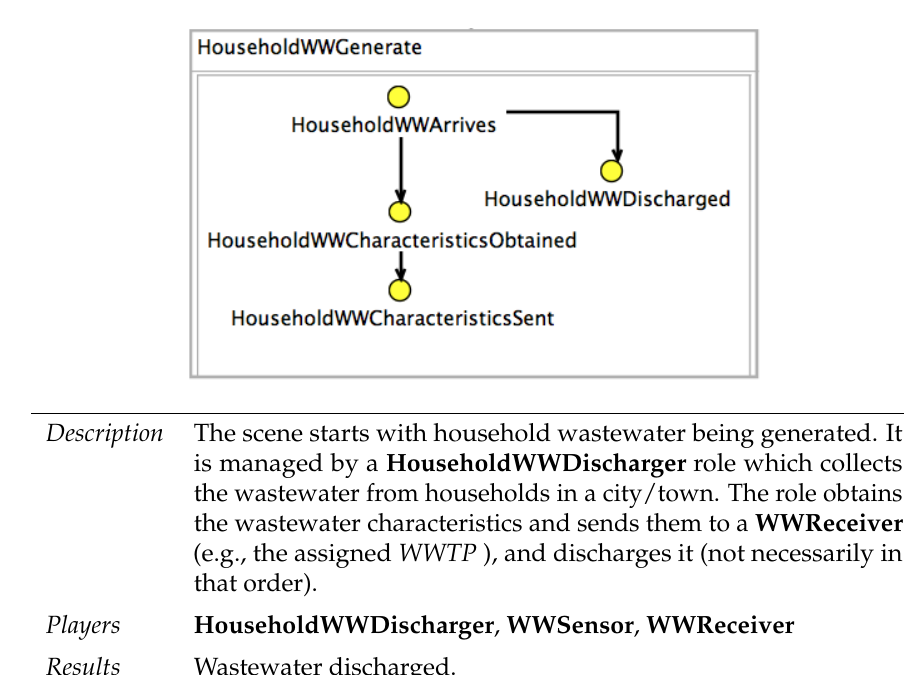
Figure A2. Landmark patterns for the household discharge. It shows the flow followed by a household wastewater discharge.